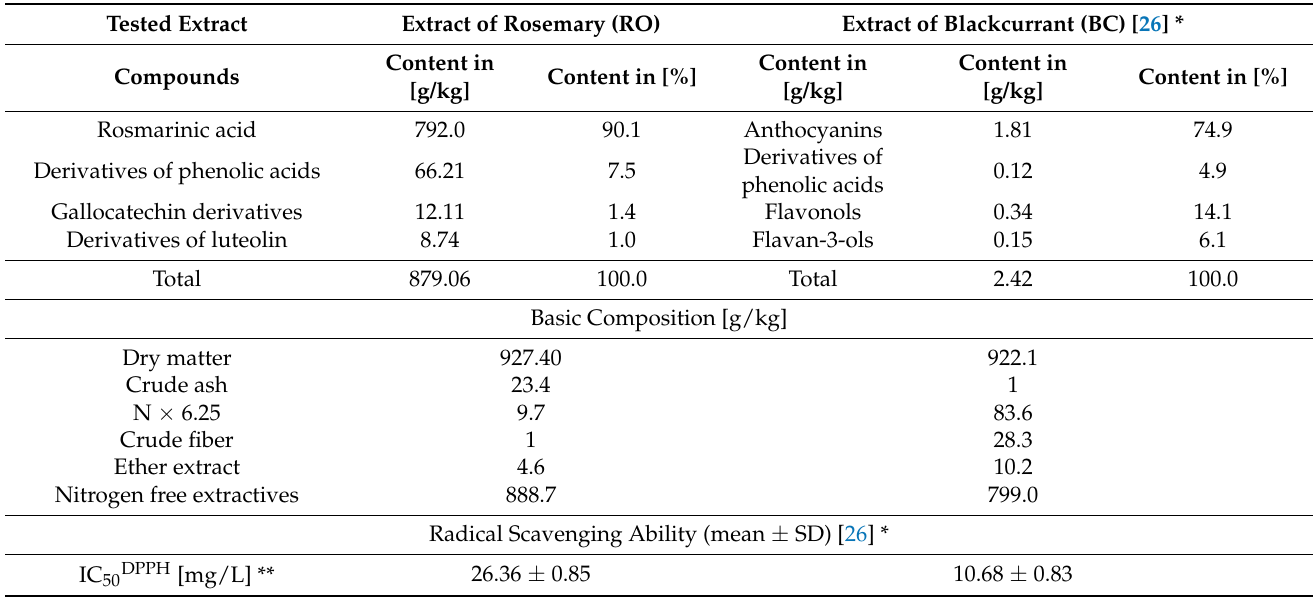
Table 2. Basic chemical composition and main polyphenolic fractions determined in the rosemary and blackcurrant extracts. Tested Extract Extract of Rosemary (RO) Extract of Blackcurrant (BC) [26] * Content in Content in Content in Content in [%] Content in [%] Compounds [g/kg] [g/kg] [g/kg] Rosmarinic acid 792.0 90.1 Derivatives of phenolic